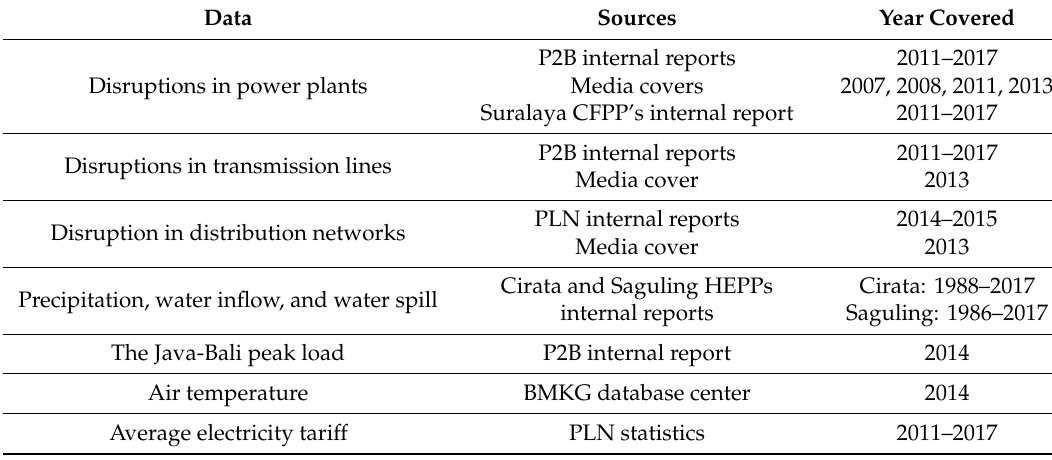
Table 3. Sources of secondary